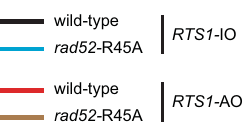
in ( a ). Data are presented as median values±interquartile range with individual datapointsshownasgreydots. n indicatesthenumberof coloniestested foreach strain. Each data point represents the frequency of Ura − His − recombinants in one ofthetested colonies.ThedataarealsoreportedinSupplementaryTable2,which includes the strain numbers and p values. Further details of the statistical analysis are reported in Supplementary Data 1. Source data are provided as a Source Data fi le. c Sequenceanalysisof Alu Sx1- Alu Sptemplateswitches.Thesequenceof Alu Sx1 is shown with homologous sequences used for template switching in red. The coloured linesaboveindicatethenumberof eventsobserved among thesubsetof colonies tested for each